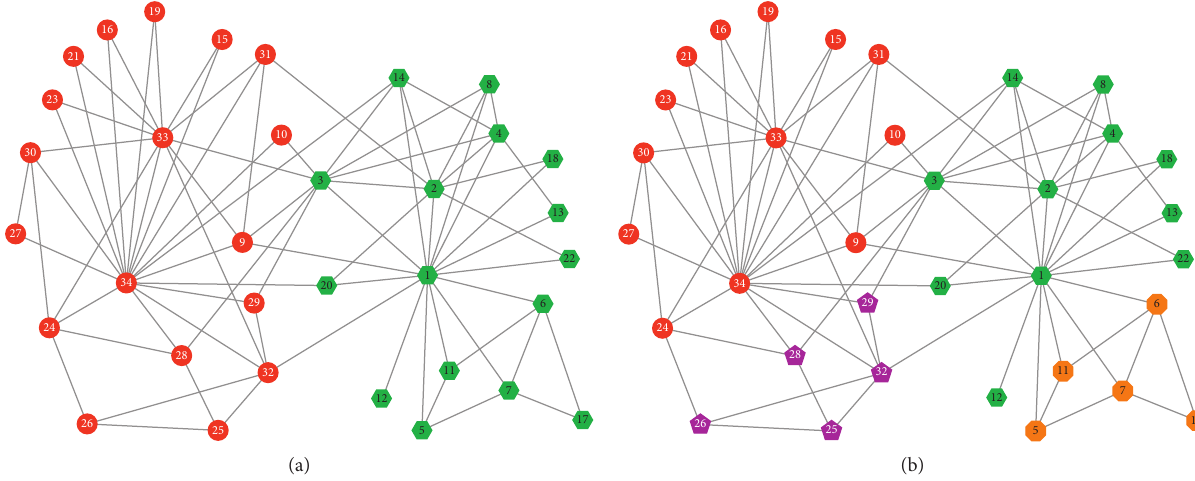
Figure 2: The karate club network. (a) The ground-truth community structure. (b) The community structure detected by the proposed